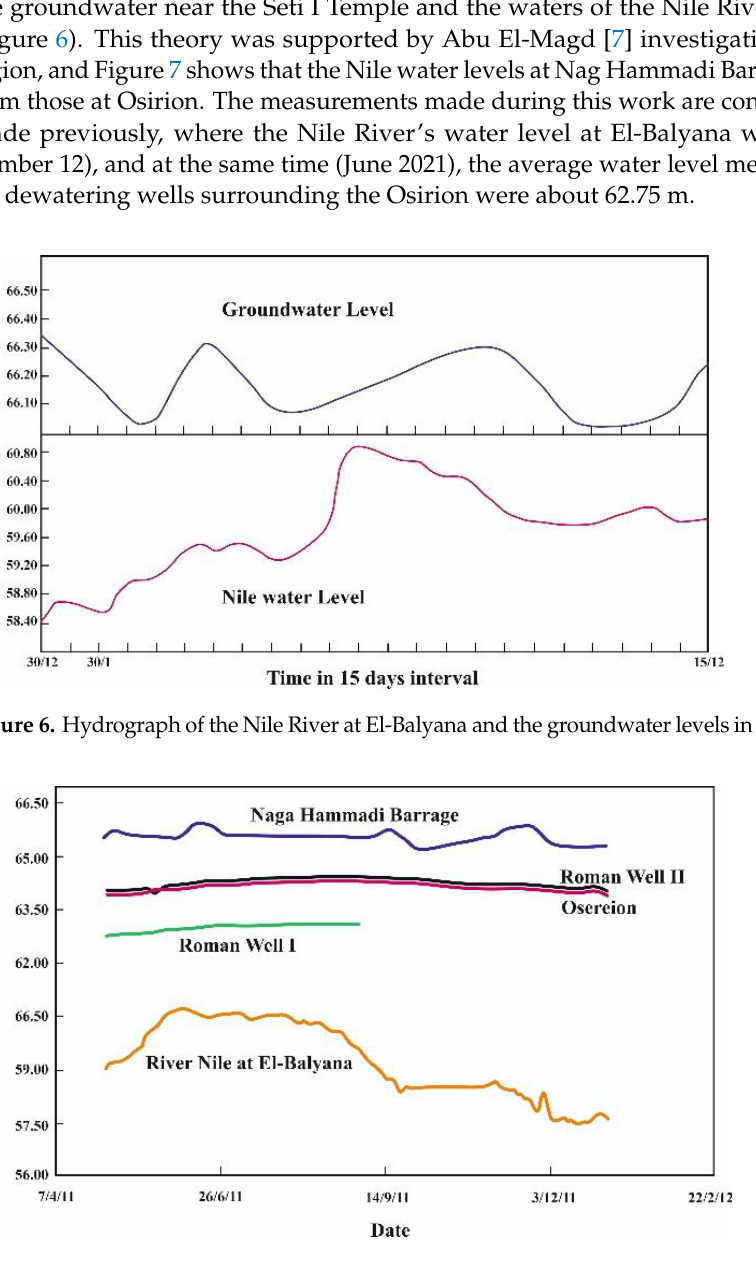
Figure 7. Hydrograph shows the water level in the Nag Hammadi upstream and water level within the study area [7].